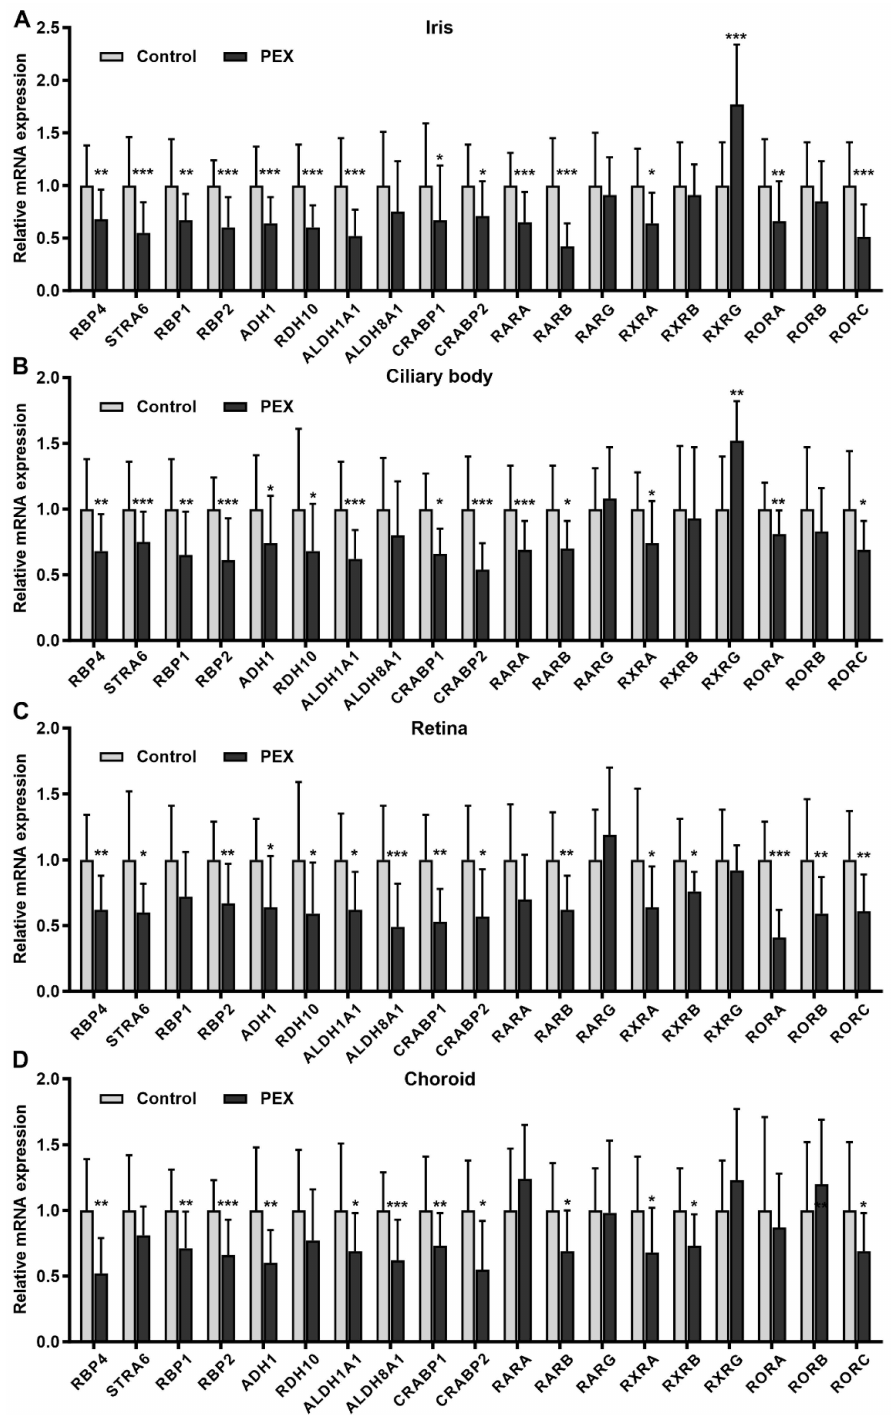
Figure 1. Comparative analysis of retinoic acid pathway components in ocular tissues of PEX and control eyes. Quantitative real-time PCR analysis of ( A ) iris, ( B ) ciliary body, ( C ) retina, and ( D )